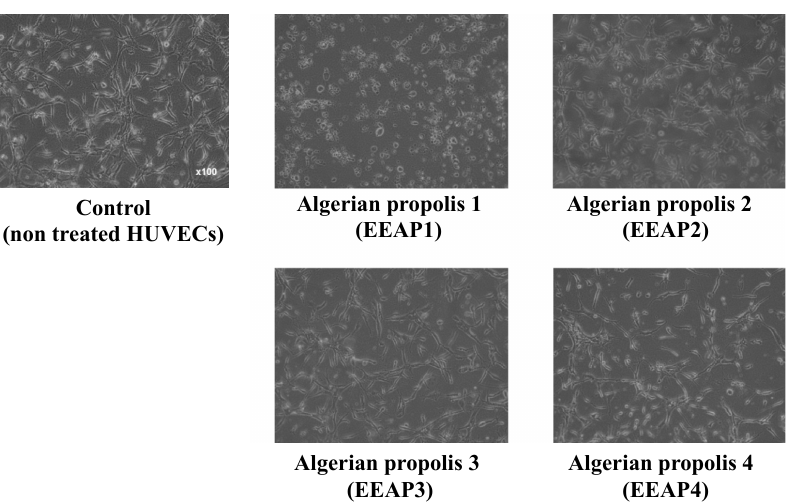
Figure 1. Inhibitory effects of ethanol extracts of Algerian propolis 1–4 (EEAP1–4) on the tube formation of HUVECs. The cells were treated with 50 µ g/mL of EEAPs and observed after 12 h. EEAP1 showed the strongest antiangiogenic activity, completely inhibiting the formation of capillary networks and inducing cell fragmentation.